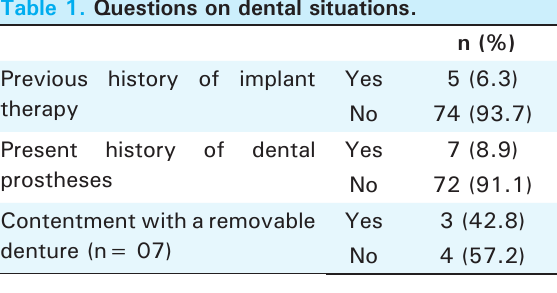
Table 1. Questions on dental situations.